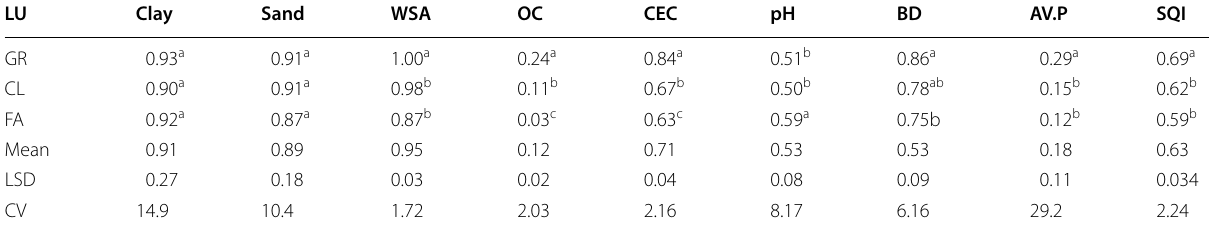
LU, Land Use; GR, Grazing Land; CL, Cultivated land; FA, Fallow Land; TP, Total Porosity; WSA, water-stable aggregate; CEC, Cation Exchange Capacity; BD, Bulk density; SQI, soil quality index; AvP, available Phosphorus Means followed by different letters within a column are significantly different from each other at 0.05 levels